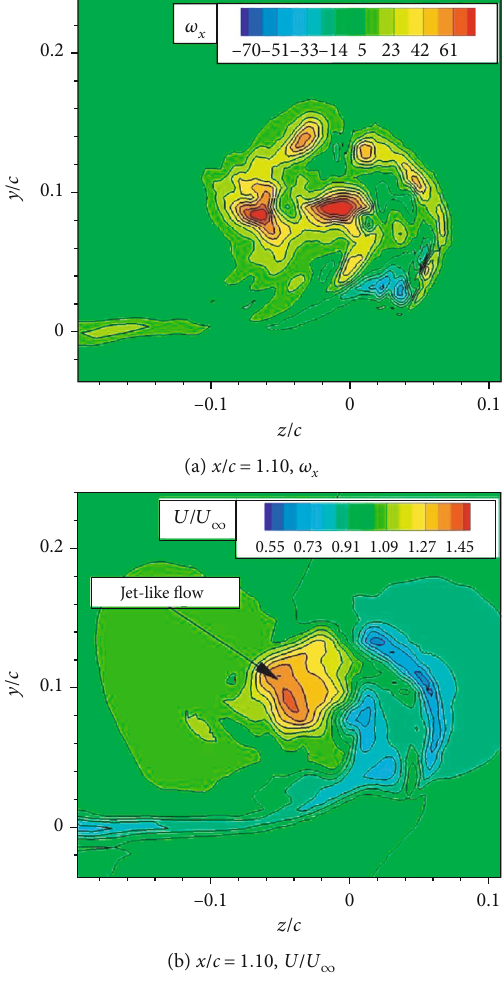
Figure 10: Instantaneous fl ow fi eld of the wingtip.